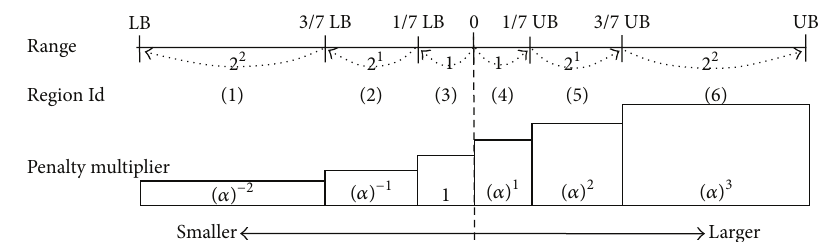
Figure 4: Penalty multiplier